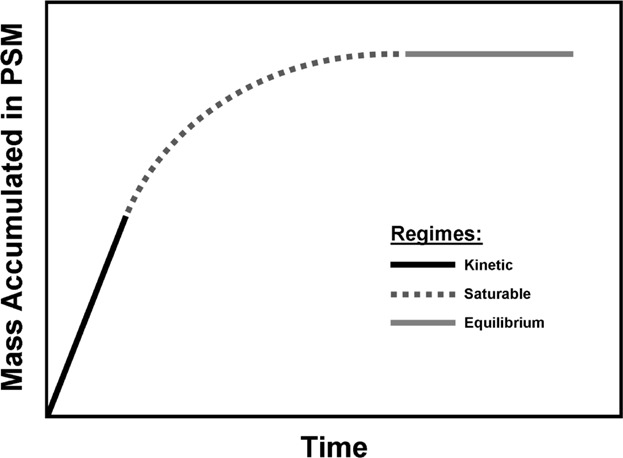
Illustration of the gap to be filled between the current generations of kinetic and equilibrium regimens traditionally used by PSMs.